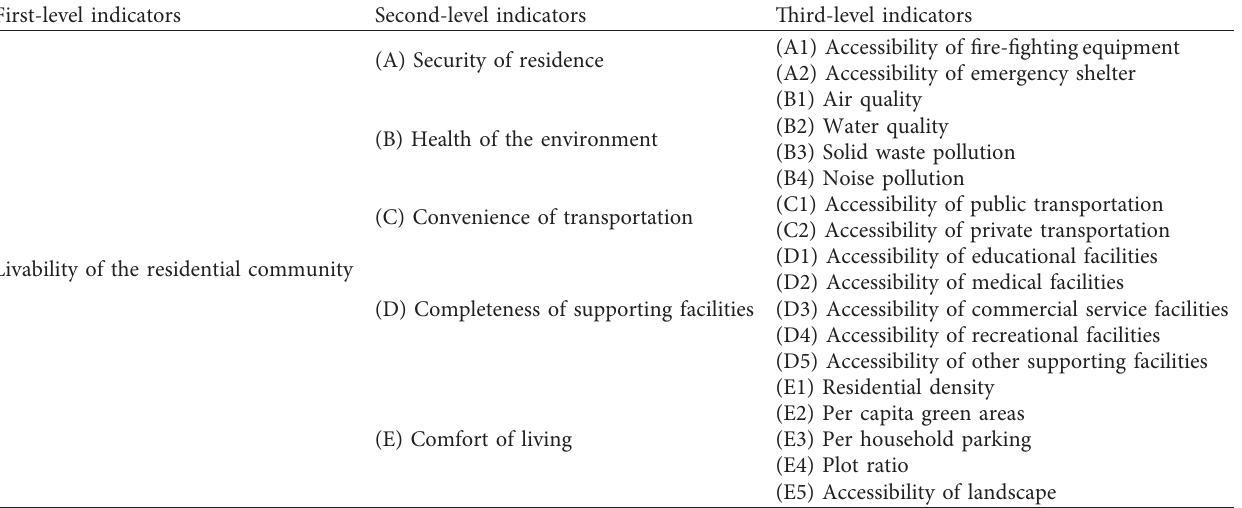
Table 1: The evaluation indicator system on the livability of residential communities in